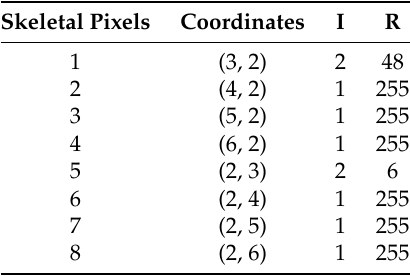
Table 1. The final 8 skeletal pixels, recorded with their coordinates, I and R information, form a skeleton